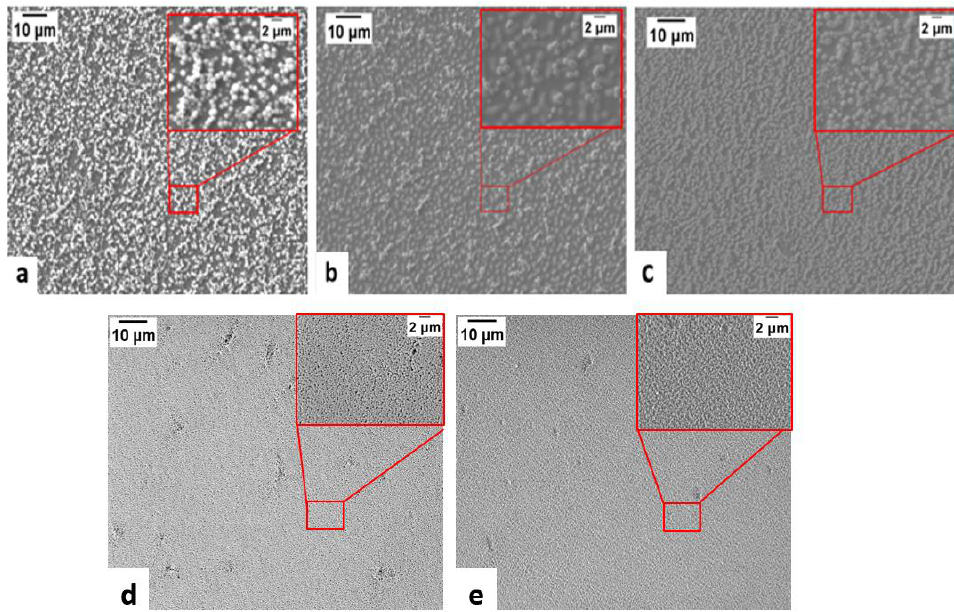
Figure 4. SEM images of coatings with particle loading (vol. %) of ( a ) 37, ( b ) 53, ( c ) 70, ( d ) 77, ( e ) 84. The inset is zoom-in SEM image.